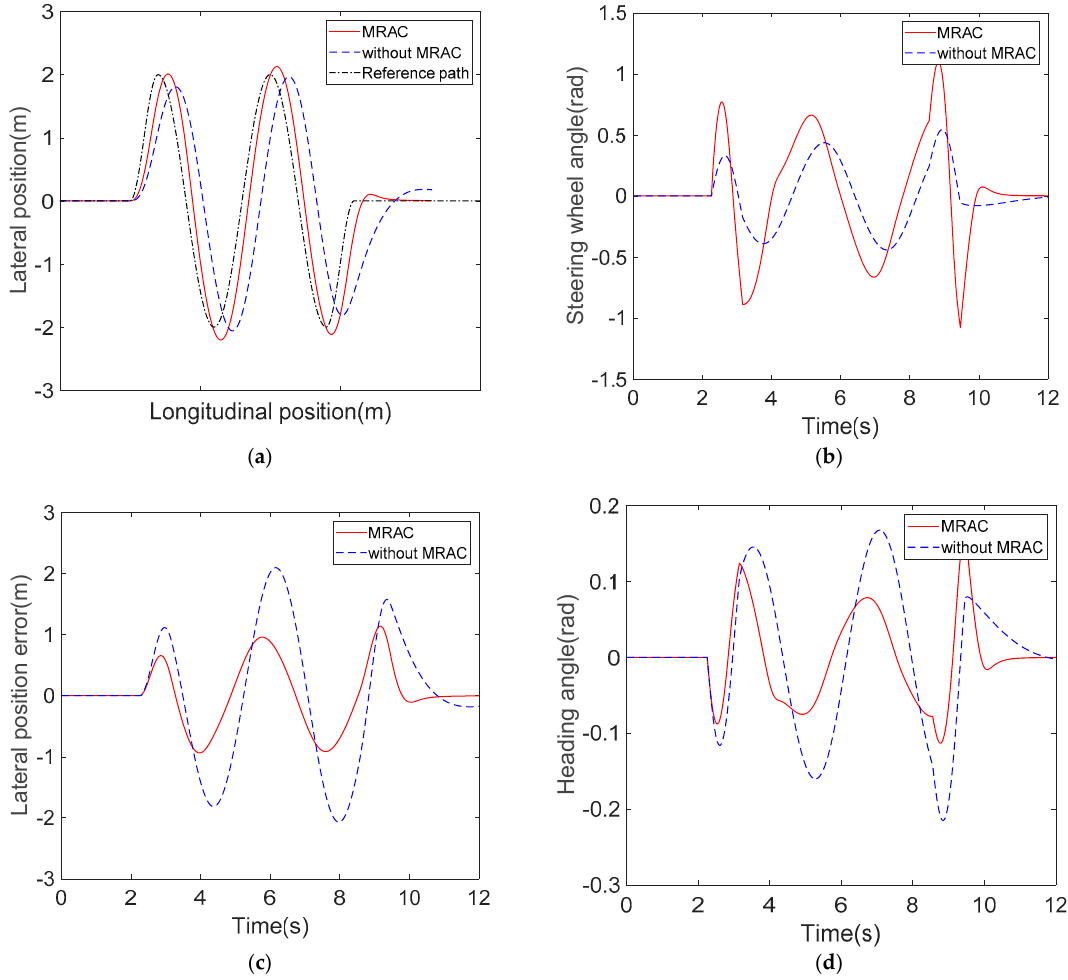
Figure 7. The simulation results for scenario 2: ( a ) Global vehicle trajectory; ( b ) Steering wheel angle; ( c ) Lateral position error; ( d ) Orientation